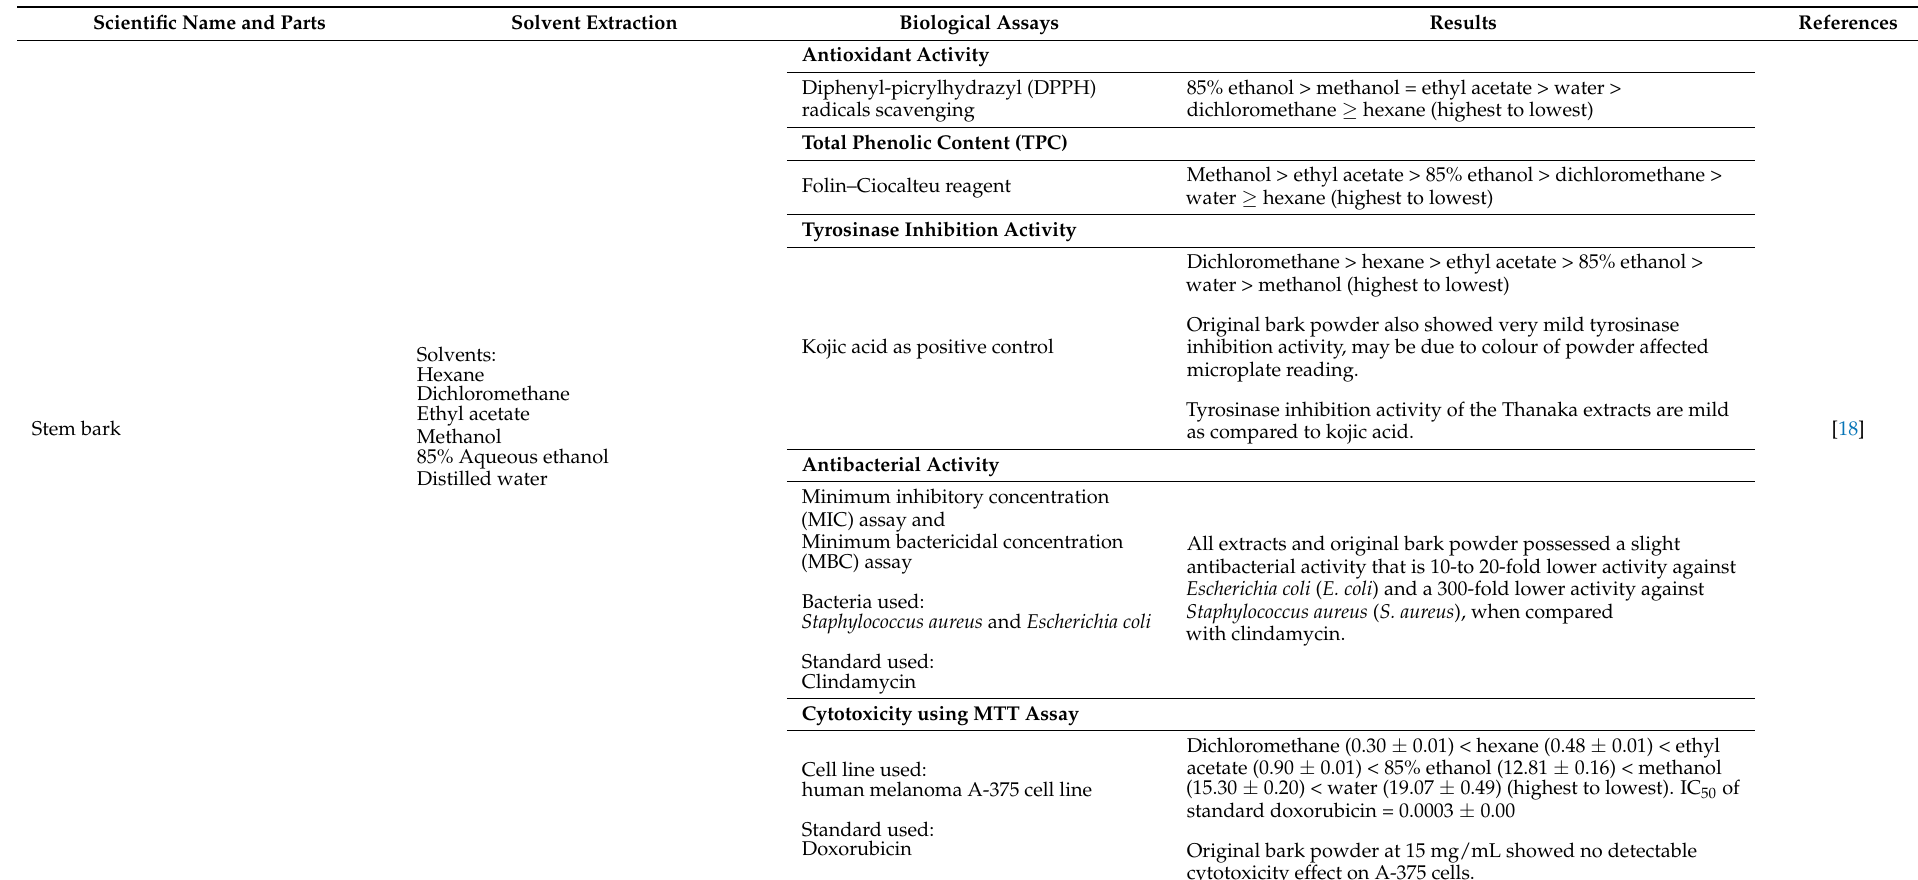
Table 3. Biological activities of